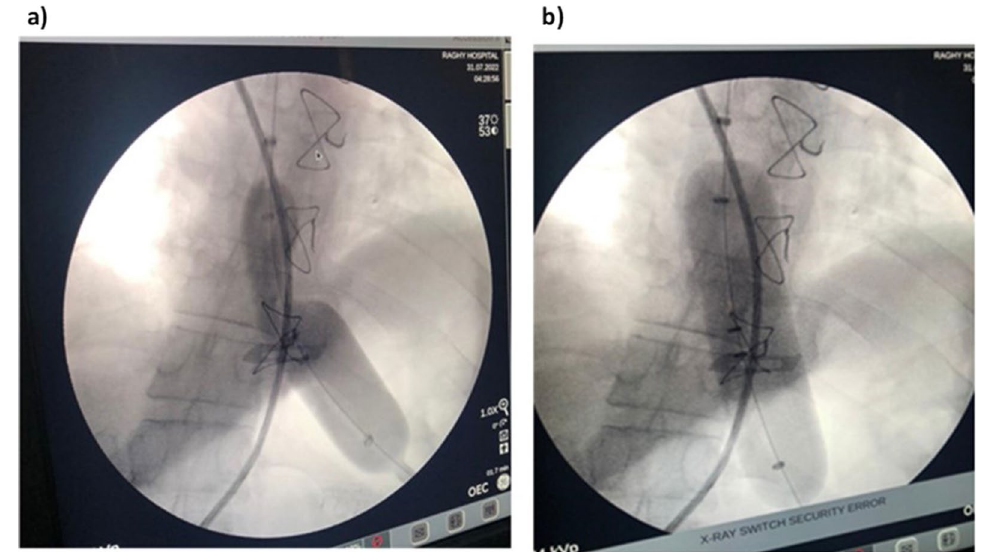
Fig. 3 Fluoroscopic image of achalasia using a 3.5-cm pneumatic dilator showing: a pneumatic balloon dilation with subsequent dilation to obliterate the balloon waist; b after successful pneumatic balloon dilation with balloon inflation to the maximum pressure of 13